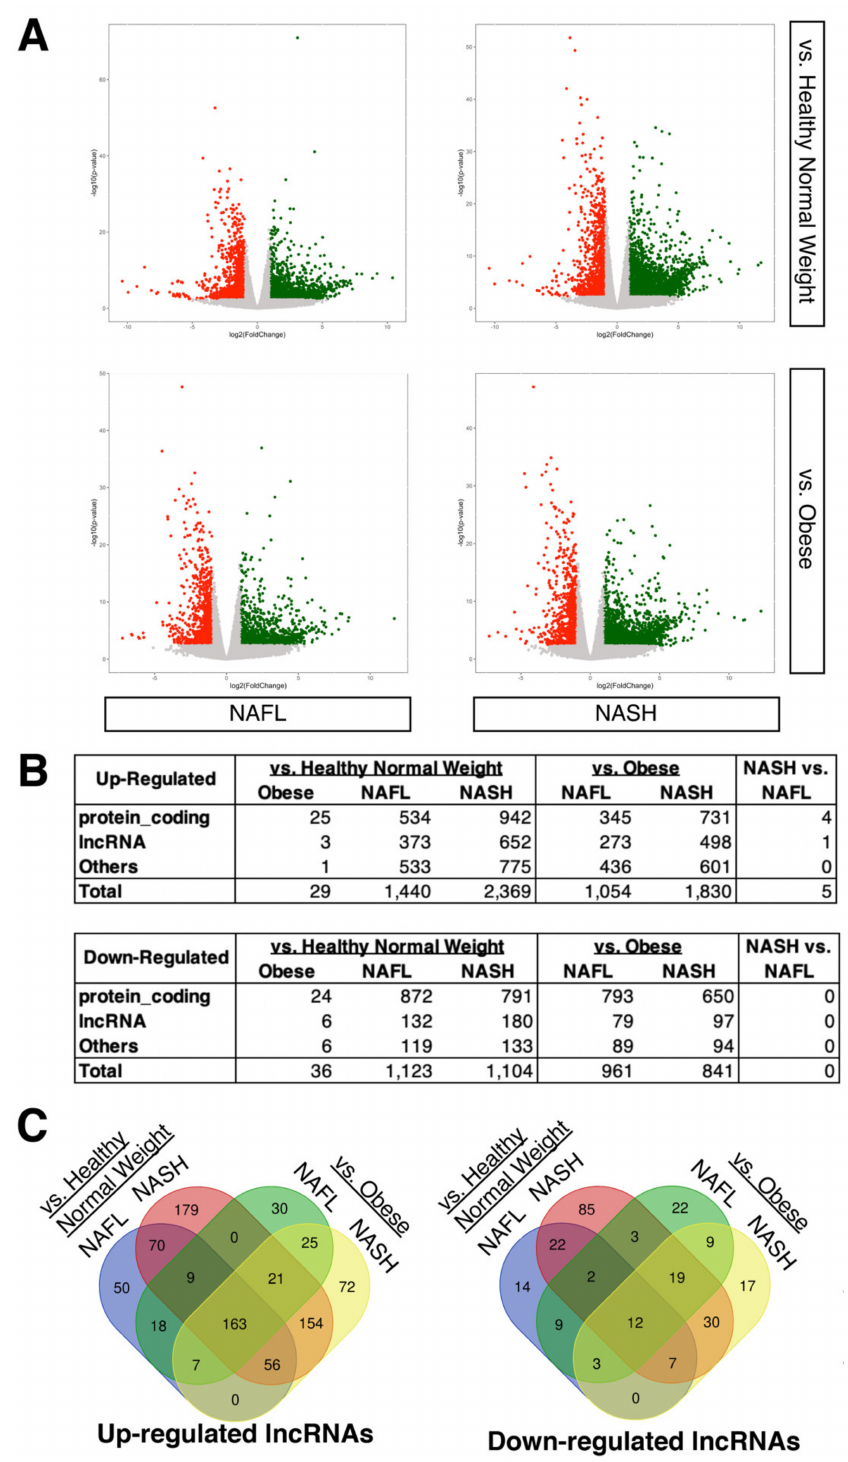
Figure 1. Gene expression profiling of NAFL and NASH patients compared to healthy normal weight and obese individuals. ( A ) Volcano plots comparing different conditions. The numbers of samples are NAFL ( n = 15), NASH ( n = 16), healthy normal weight ( n = 14), and obese individuals ( n = 12). Up-regulated genes are colored in red, and down-regulated genes are in green. ( B ) Tables of differentially expressed genes. The Others category includes any genes other than protein-coding or lncRNAs based on the biotypes provided by the Ensembl database. ( C ) Venn diagrams of up- and down-regulated